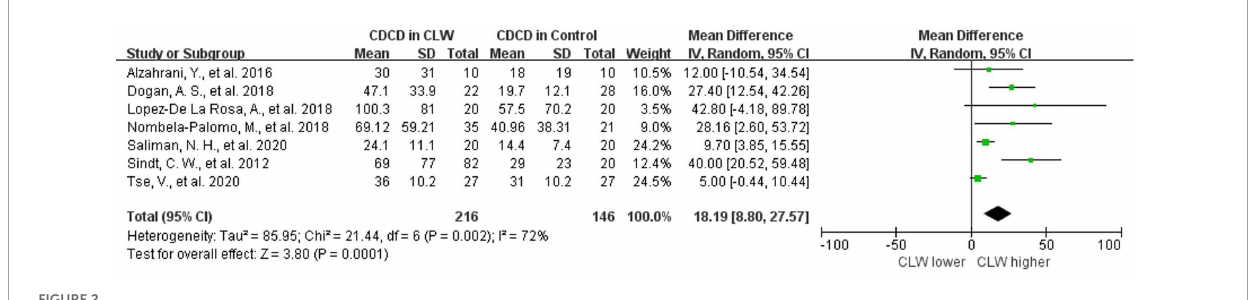
FIGURE2 Forest plot of CDCD in CL wearer vs. control group. CI, confidence interval; IV, inverse variance; SD, standard deviation; CLW, contact lens wearers; CDCD, corneal dendritic cell density.